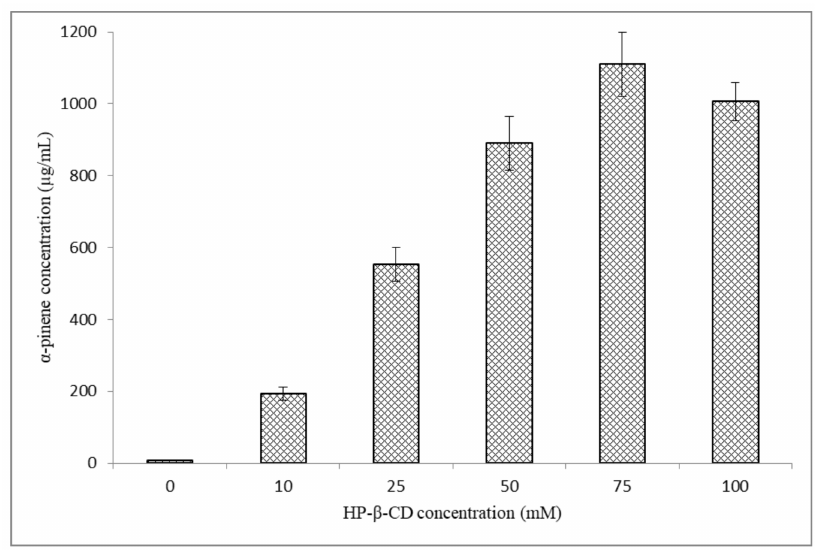
Figure 2. The variation of α -pinene concentration in the filtrate as a function of HP- β -CD